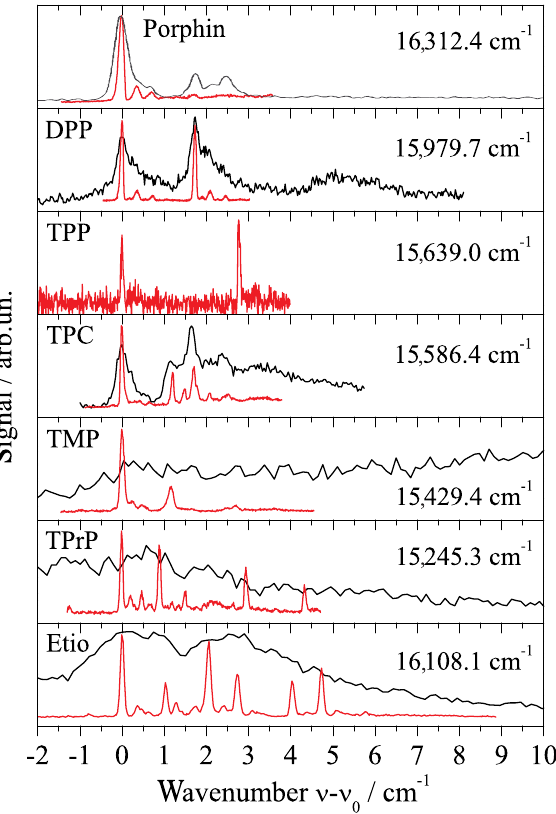
Figure 6. Electronic origin of the fluorescence excitation spectra of porphyrin derivatives (as indicated in each panel) in helium droplets all recorded with laser intensity beyond (black) and below (red) the saturation limit. DPP: diphenyl-porphyrin; TPP: tetraphenyl-porphyrin; TPC: tetraphenyl-chlorin; TMP: tetramethyl-porphyrin; TPrP: tetrapropyl-porphyrin; Etio: tetraethyl-tetramethyl-porphyrin. For each dopant species the absolute wavenumber ¯ ν 0 is added to the